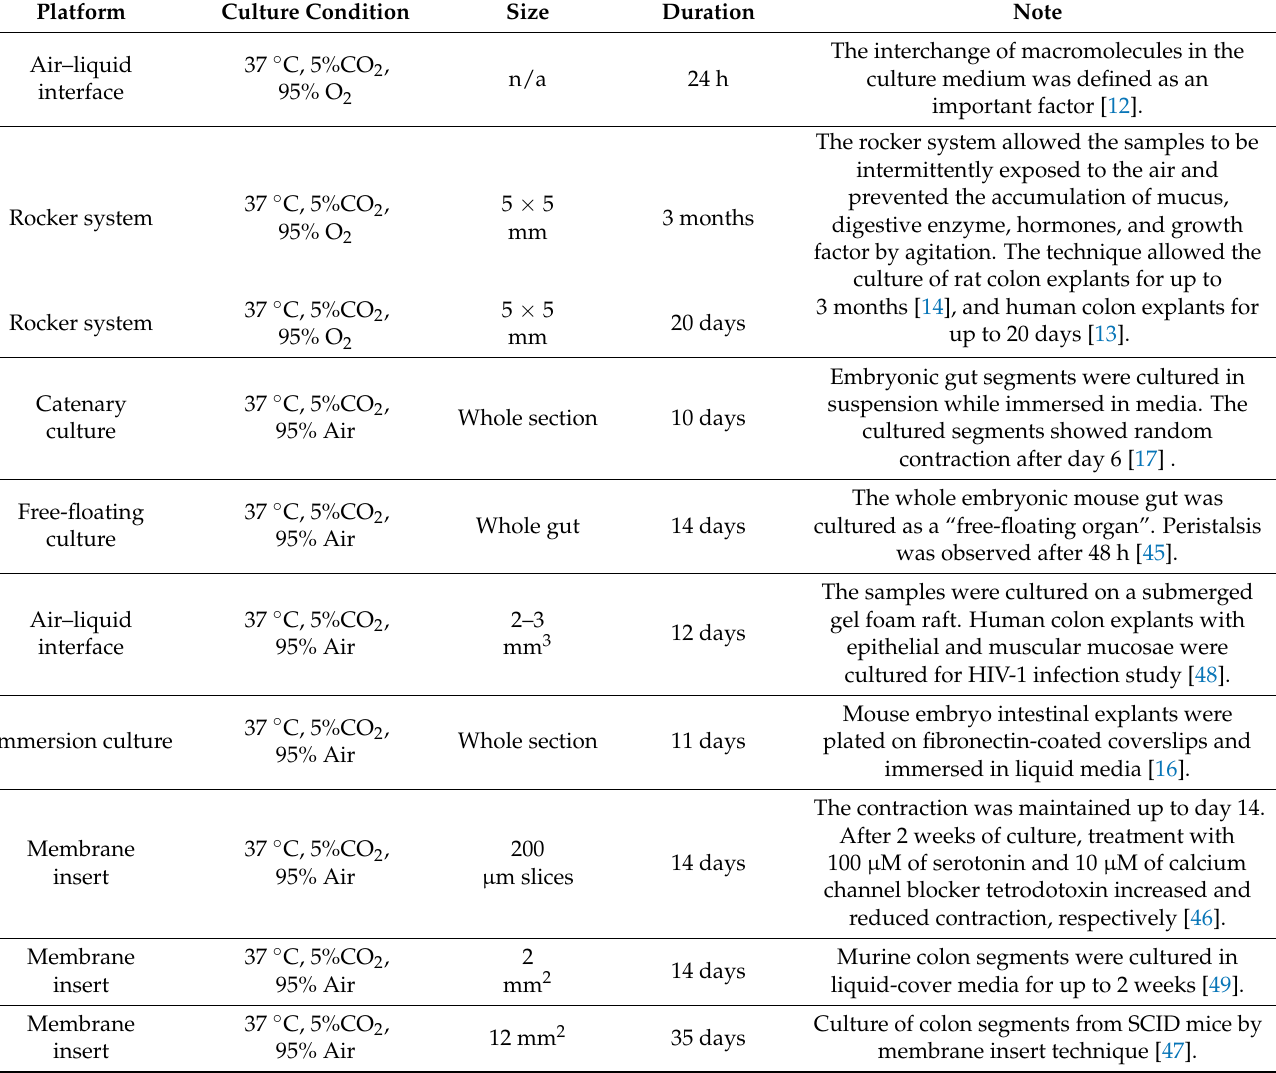
Table 1. Summary of existing gut explant culture platforms and culture